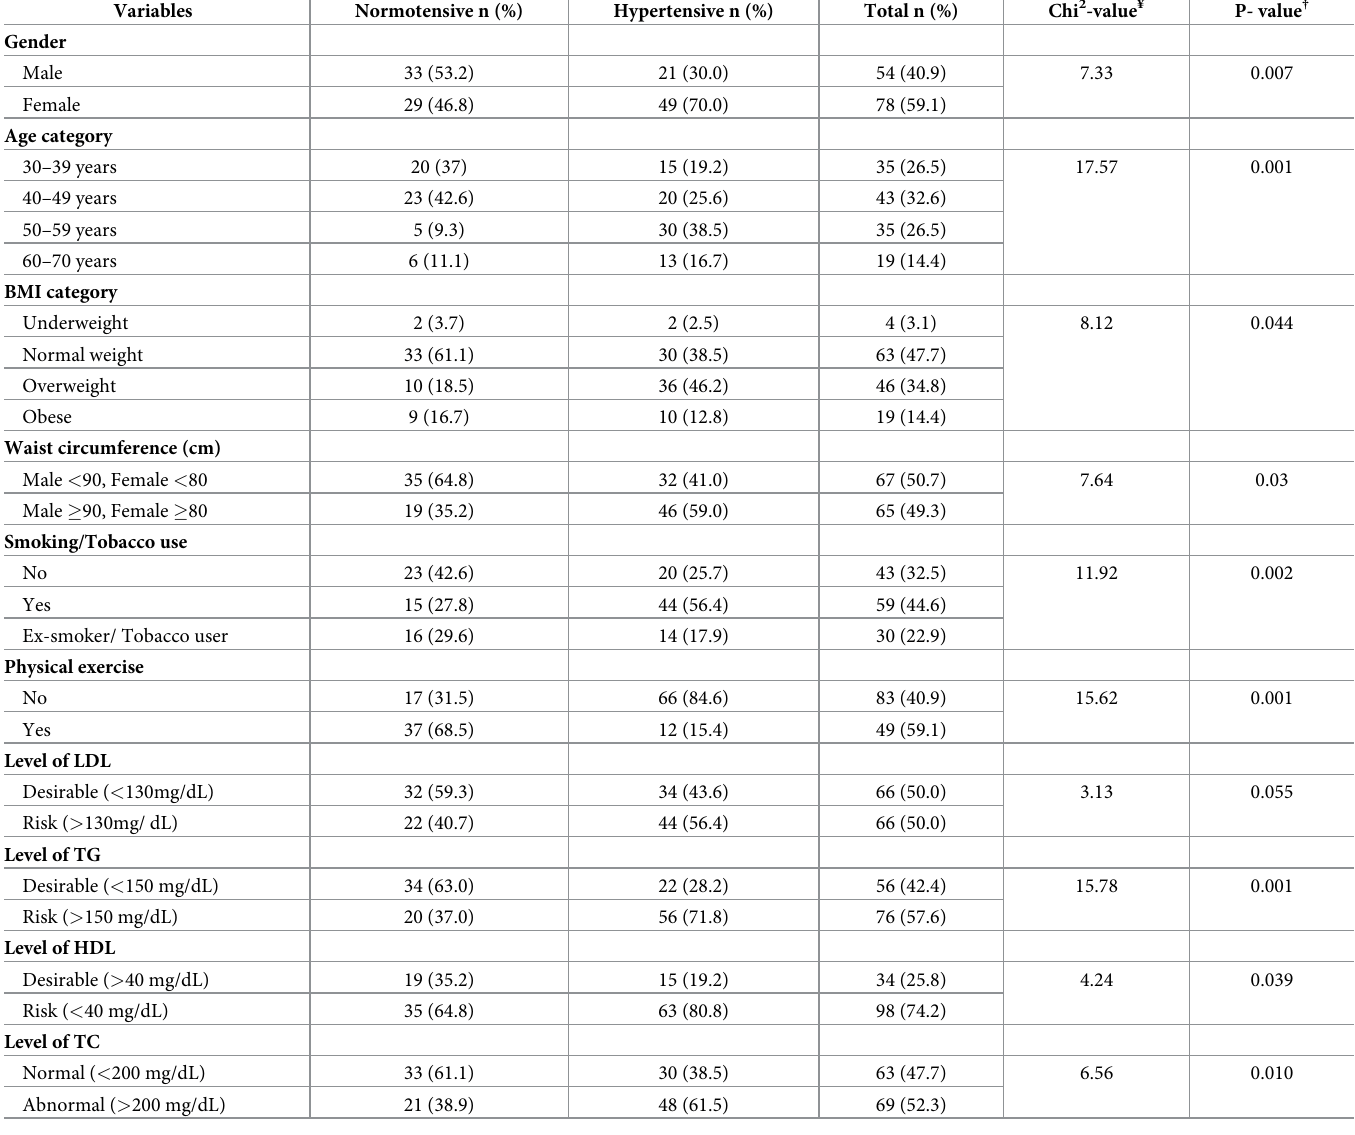
Table 3. Relationship between different clinical status and blood pressure types of the